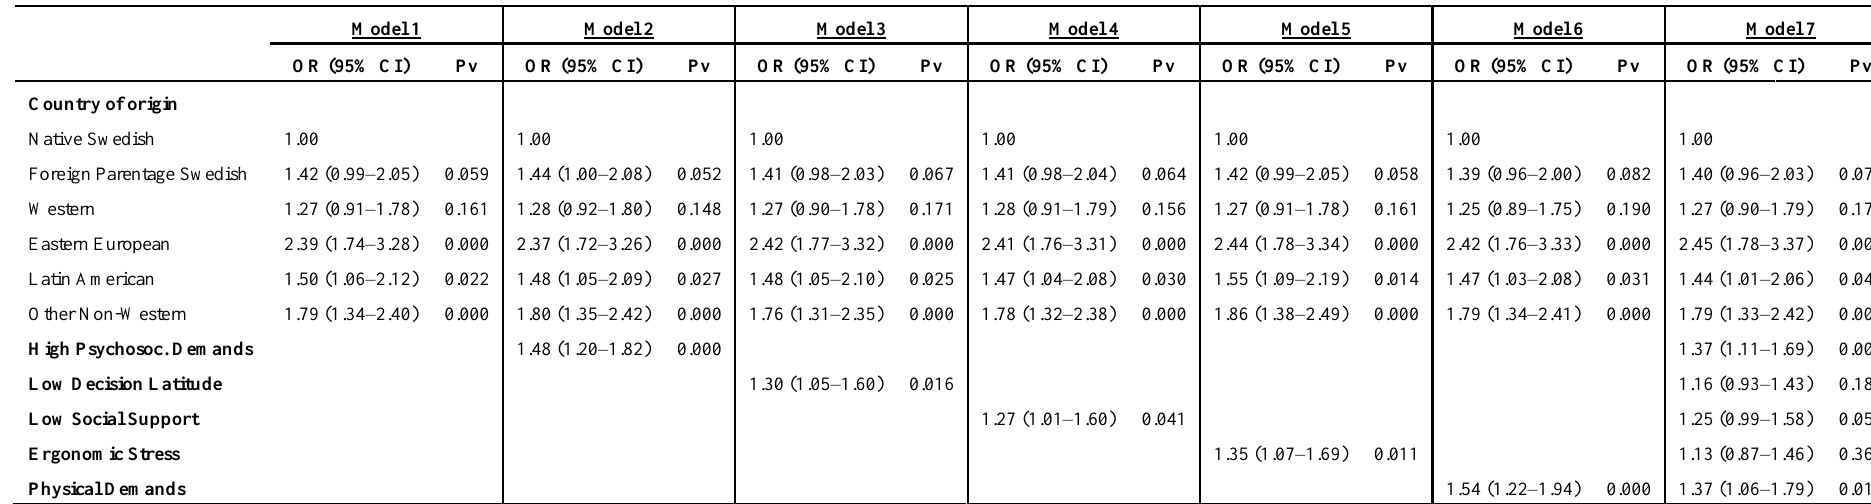
Table 2. Multivariate regression analysis of risk for poor self-rated health among foreign background workers in